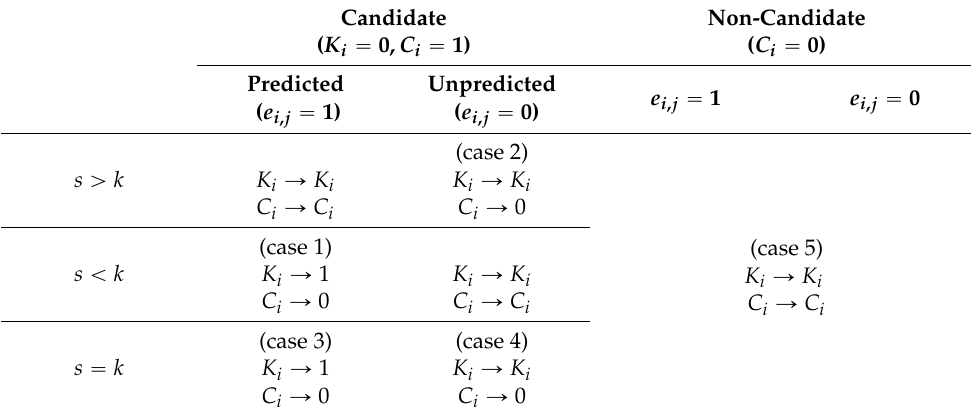
Table 4. Values of K i and C i according to the cases in S k LE S